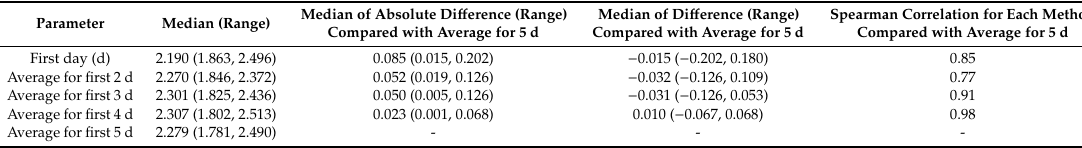
Table 4. Average acceleration of leg